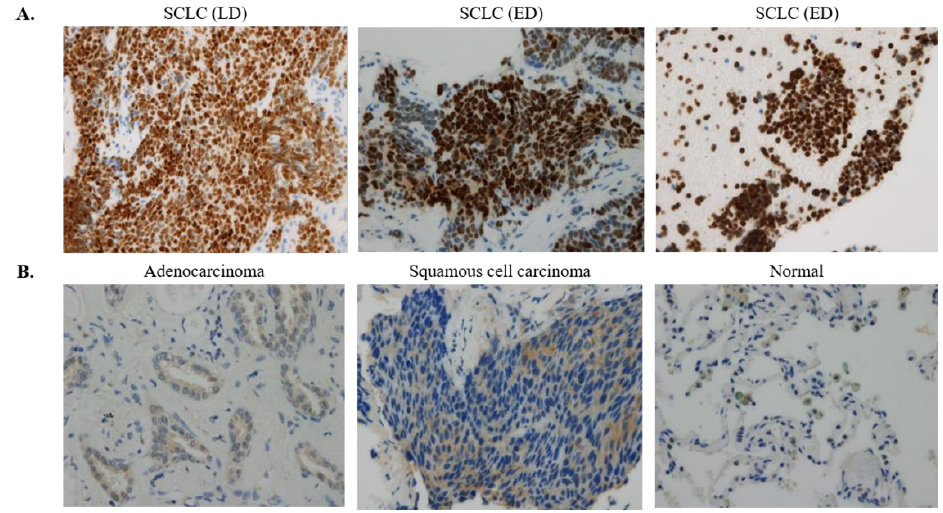
Figure 3. Immunohistochemical staining of NOL4 proteins. Panels refer to representative sections showing positive staining ( A ) and negative staining ( B ). Original magnification is 100×.